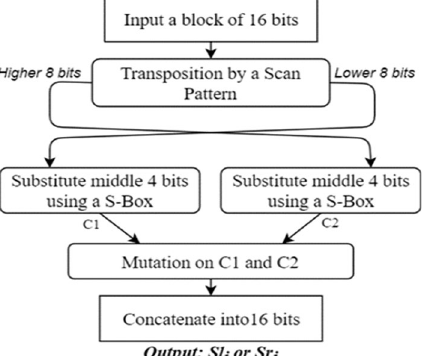
Fig. 7 The G-function for each round of RBFK cipher with 16 bit input and 16 bit